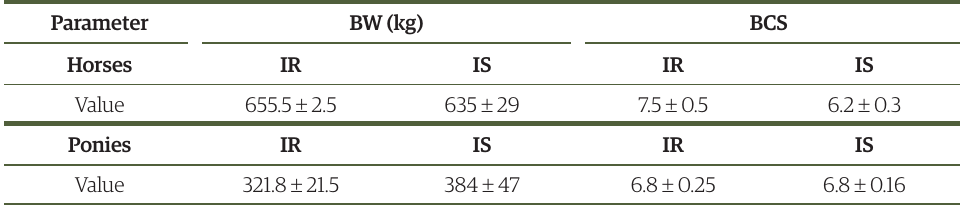
Table 4. Values of body weight (BW) and body condition score (BCS) for insulin resistant (IR) versus insulin sensitive (IS) horses and